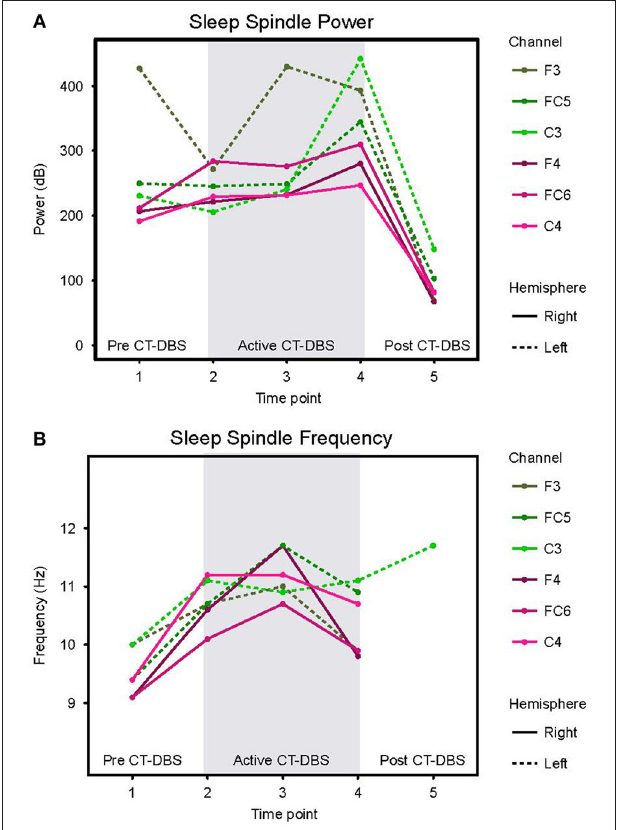
FIGURE 4 | Stage two sleep spindle dynamics. Power spectra were calculated for representative stage two sleep EEG segments and values normalized for comparison across time points. (A) Power in the 9–16Hz spindle range, plotted according to channel and time point. (B) Peak spectral frequency in the 9–16Hz spindle range. If no spectral peak was present, spindles were considered absent and no frequency value was recorded. Dotted lines represent left hemisphere channels and solid lines represent right hemisphere channels. Individual channels are plotted by color. Gray shading indicates active CT-DBS time points.